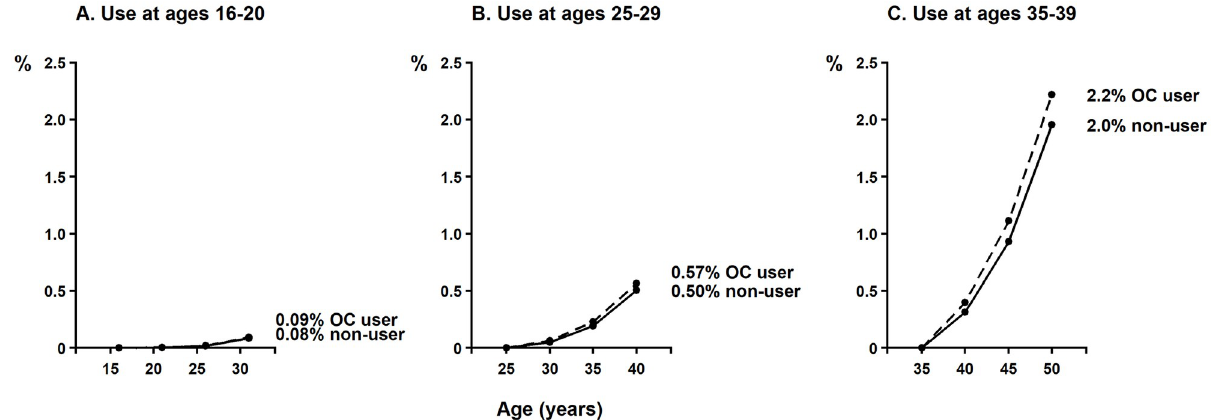
Fig 6. Absolute risk (%) of breast cancer over a 15-year period associated with 5 years use of OCs at different ages. Absolute risks include the excess risks in current users during the 5 years when the OC is used and the excess risks in the 10 years after stopping. There is no excess risk more than 10 years after stopping. OC, oral